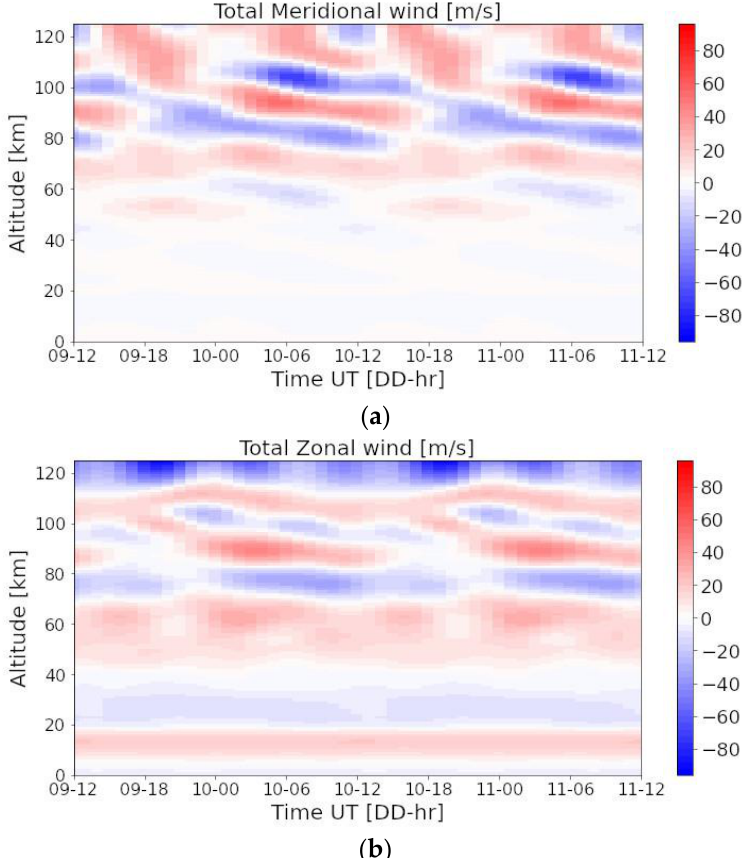
Figure 3. Meridional ( a ) and zonal ( b ) wind from HWM14 during 9 – 11 October 2017 above the Maïdo observatory.